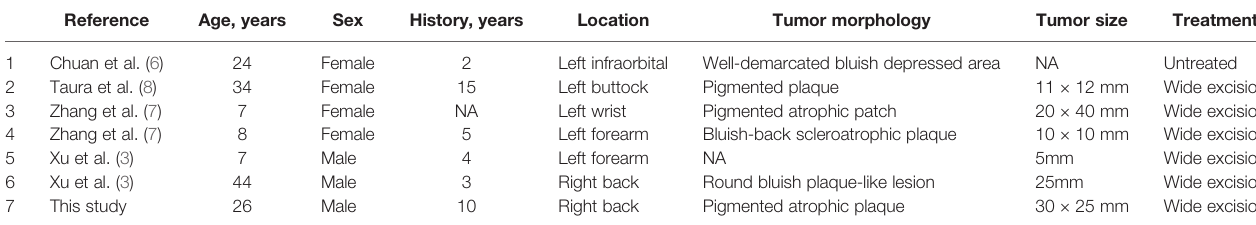
TABLE 1 | Clinical features of seven cases of atrophic pigmented dermato fi brosarcoma